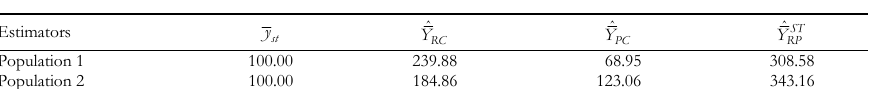
ˆ ˆ y , Y , Y and st RC PC (in case of proportional